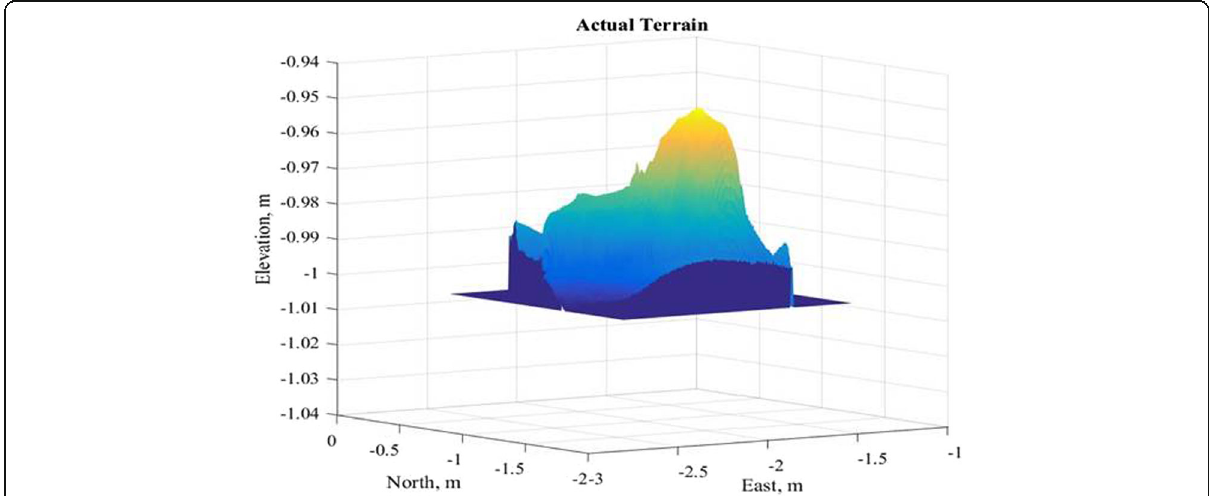
Fig. 7 Elevation model from TLS point cloud of the simulated fan model at t